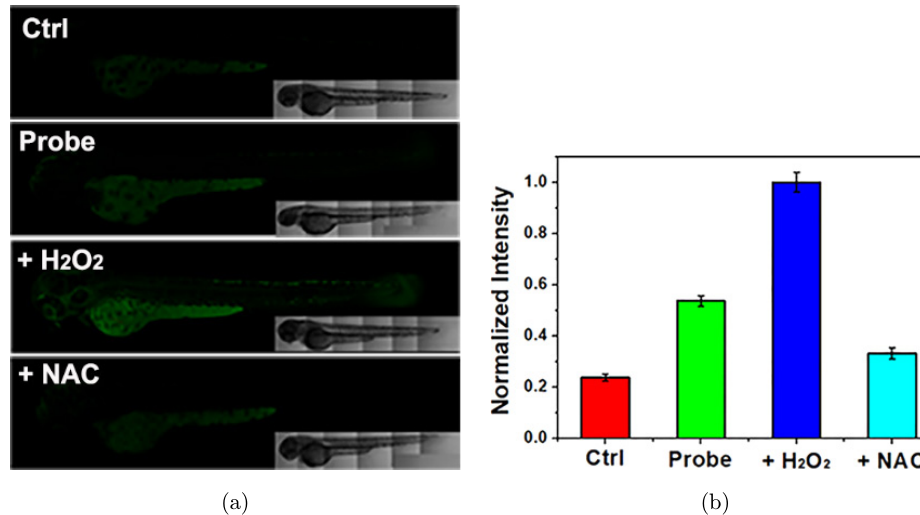
Fig. 5. (a) Confocal images of zebra¯sh (5-day-old) with CBH for 30 min and incubated with H 2 O 2 or pretreated with NAC. (b) Relative °uorescence intensities of